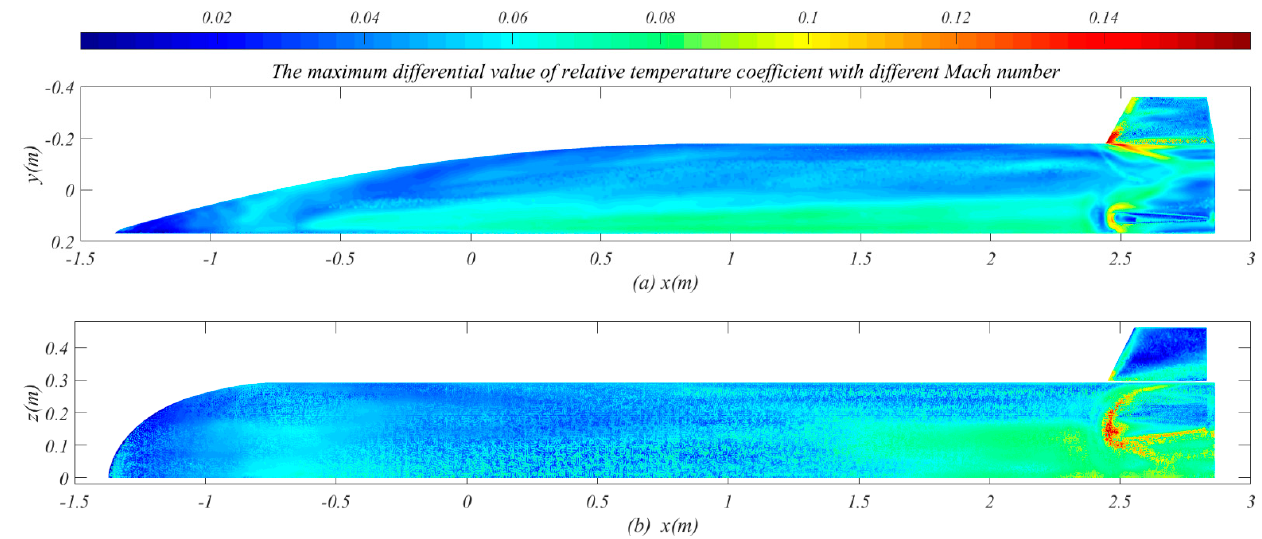
Figure 11. The maximum differential value of relative temperature coefficient with different altitude: ( a ) the side view of aircraft; ( b ) the top view of aircraft.